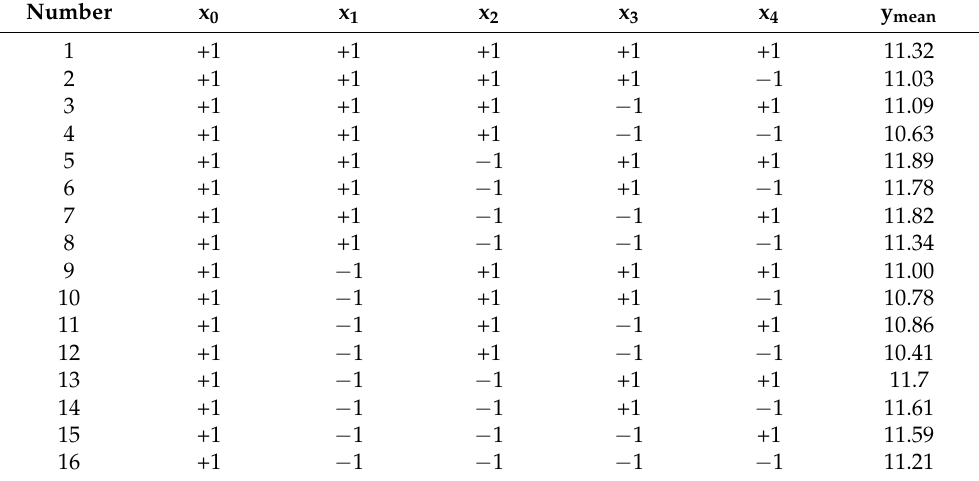
Table 2. The matrix of the